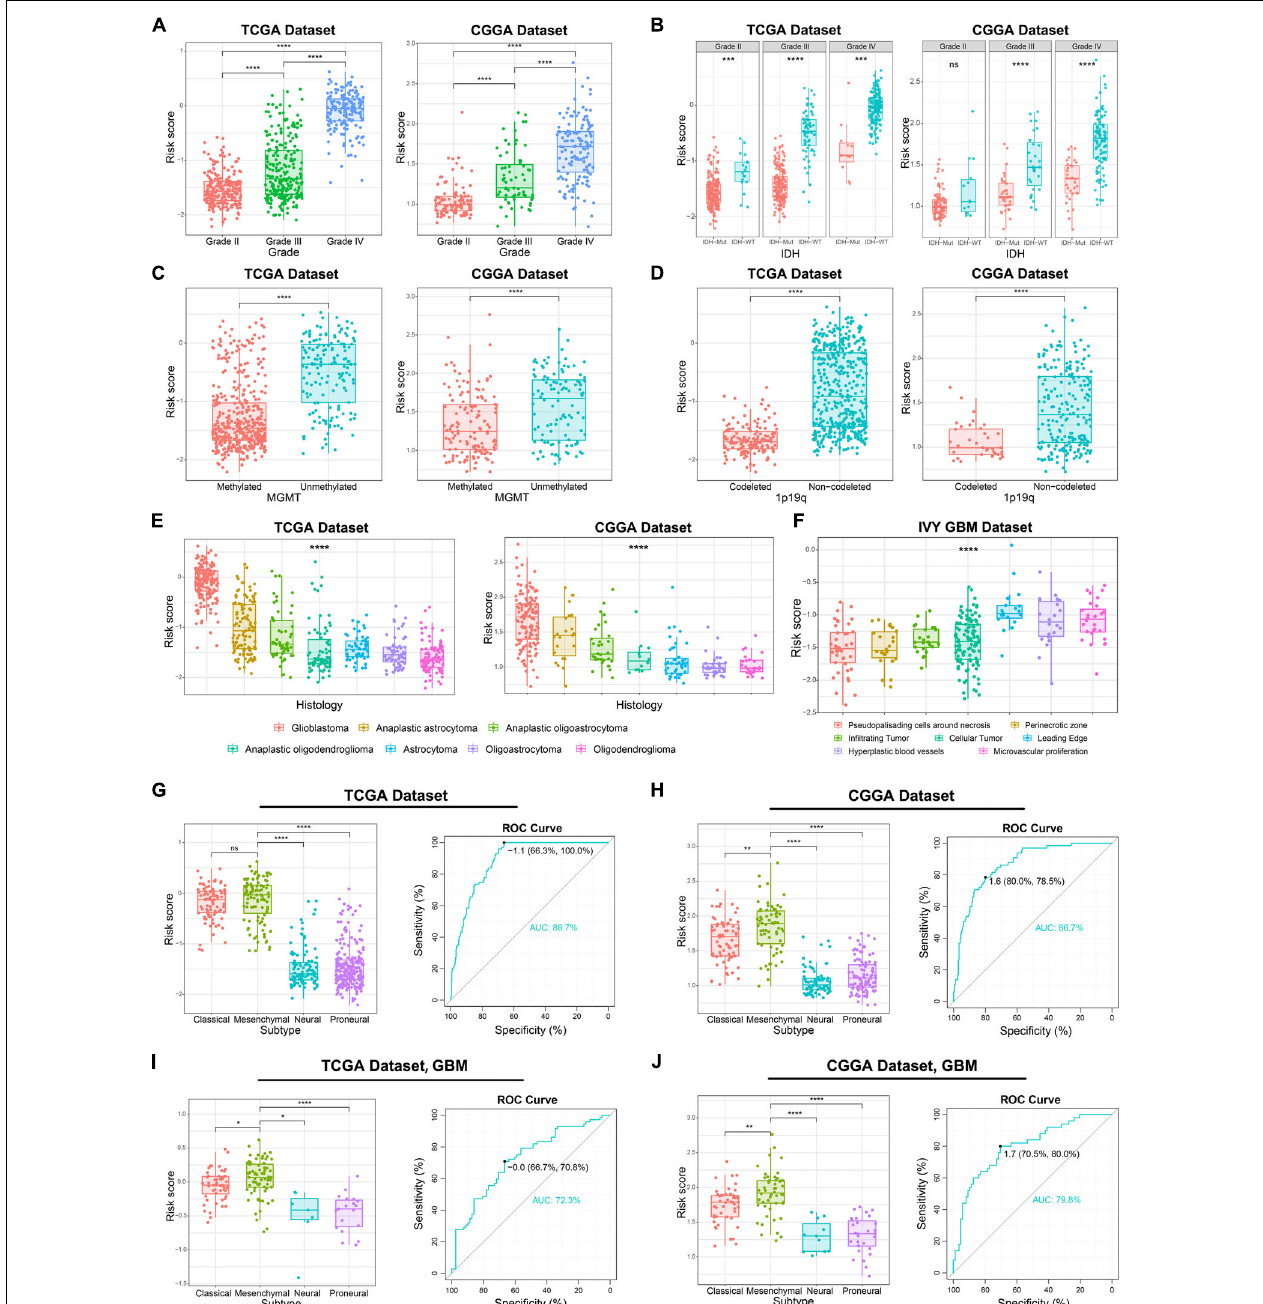
FIGURE 2 | Association between the ER stress-related signature and clinicopathologic features in TCGA and CGGA datasets. (A–E) The association between risk score and WHO grade (A) , IDH mutation status (B) , MGMT promoter methylation (C) , 1p/19q co-deletion status (D) and histopathologic classification (E) of glioma patients. (F) The distribution of risk score in the different location of GBM in IVY GBM dataset. (G,H) In glioma samples, the Mesenchymal subtype had the highest risk score among four molecular subtypes. ROC curves predicted ER stress activation as a biomarker of Mesenchymal subtype glioma. (I,J) In GBM samples, the Mesenchymal subtype had the highest risk score among four molecular subtypes. ROC curves predicted ER stress activation as a biomarker of Mesenchymal subtype glioma. * p < 0.05, ** p < 0.01, *** p < 0.001, **** p < 0.0001, ns: no statistically